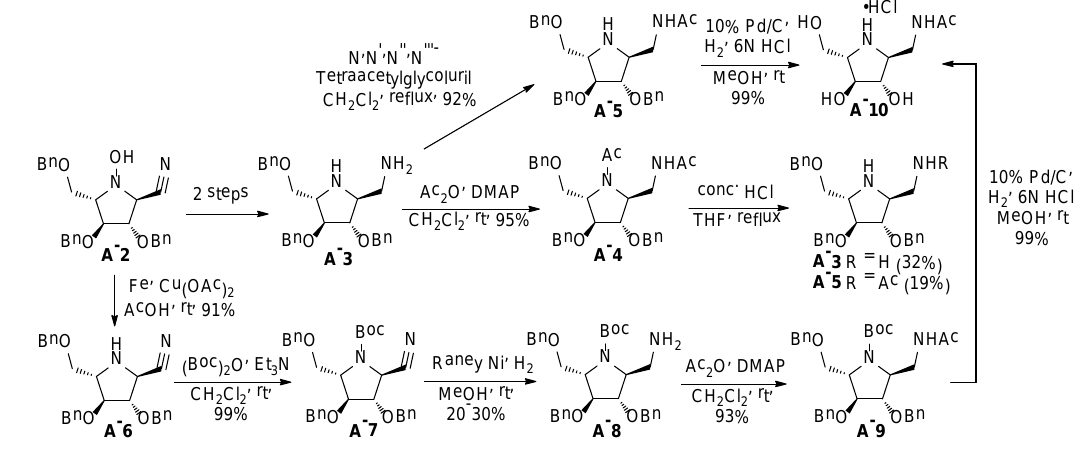
Table 1. 1-Amino and 1- N -acetylamino pyrrolidine analogues synthesized from cyclic nitrones. Entry Cyclic Nitrone Hydroxylamine Diamine